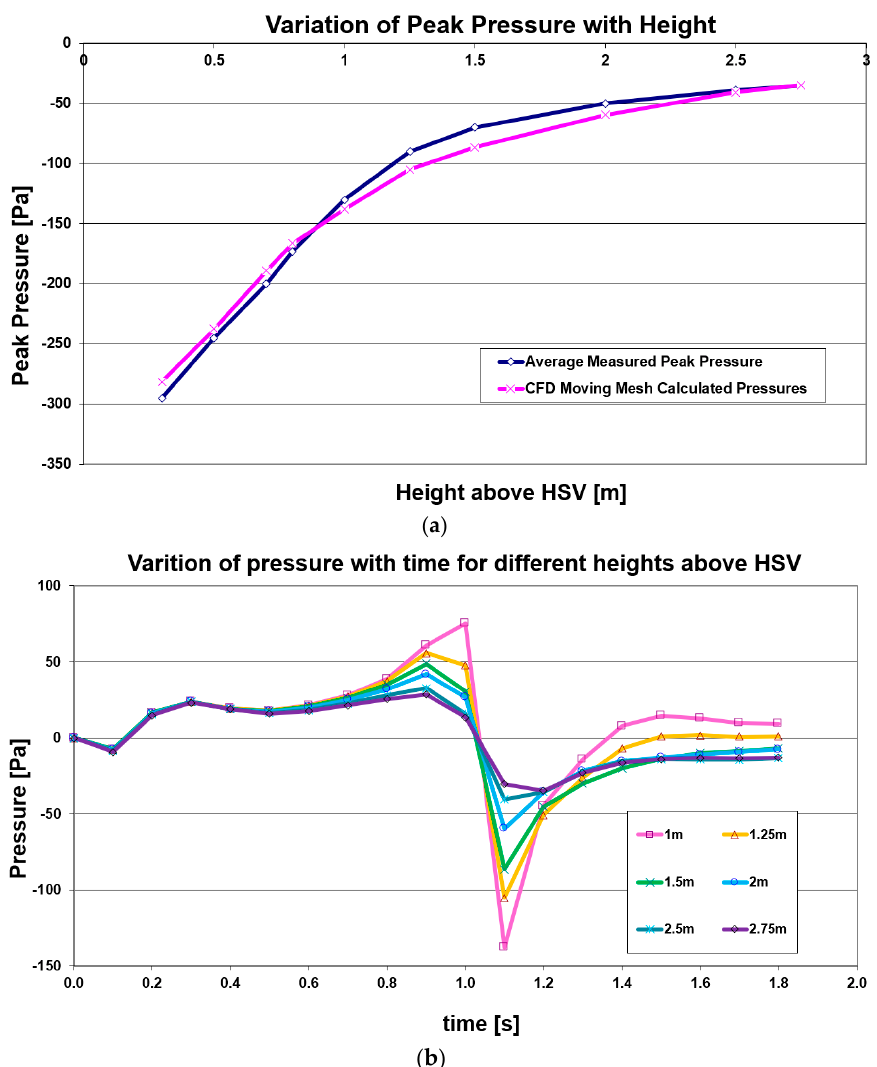
Figure 9. ( a ) Comparison of average peak pressure results for field study and computational fluid dynamic (CFD) zonal simulation and ( b ) calculated time-history pressure records at different height above the HSV.